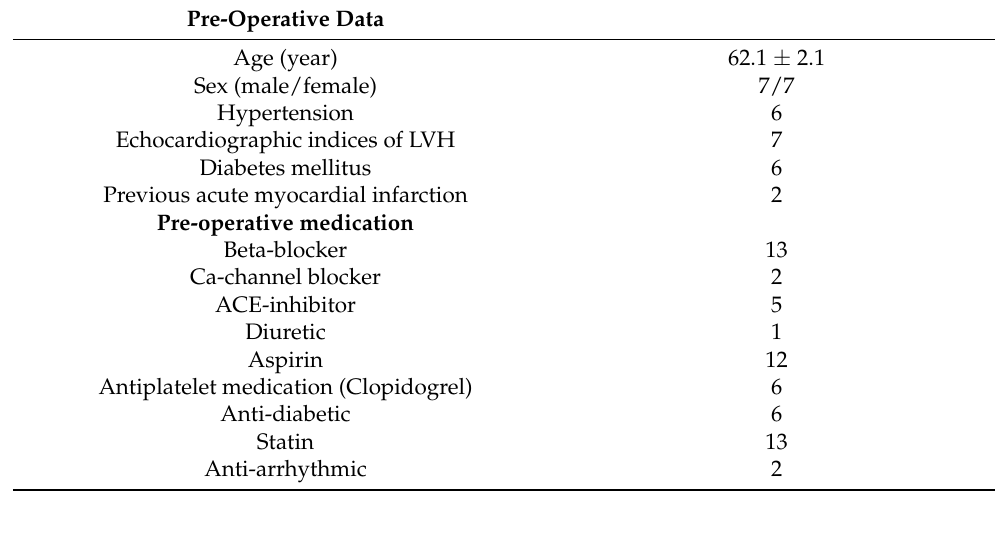
Table 1. Pre-operative characteristics and medications of CABG patients. Data are expressed as means ± SEM. Data were compared using 2-tailed independent t -test. GABG—coronary artery bypass graft surgery; LVH—left-ventricular hypertrophy.